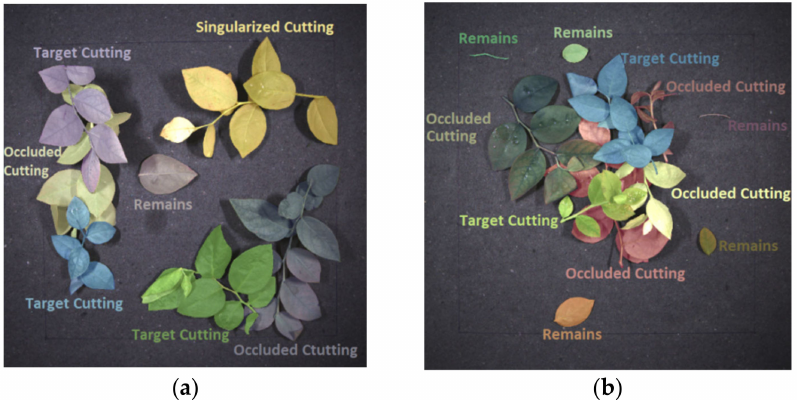
Figure 3. Examples of annotated images from the occluded plants dataset. ( a ) Normal occlusion image. ( b ) Complex occlusion